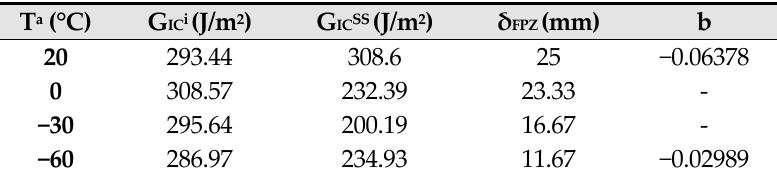
Table 2. Gompertz parameters obtained from AS4/8552 material.